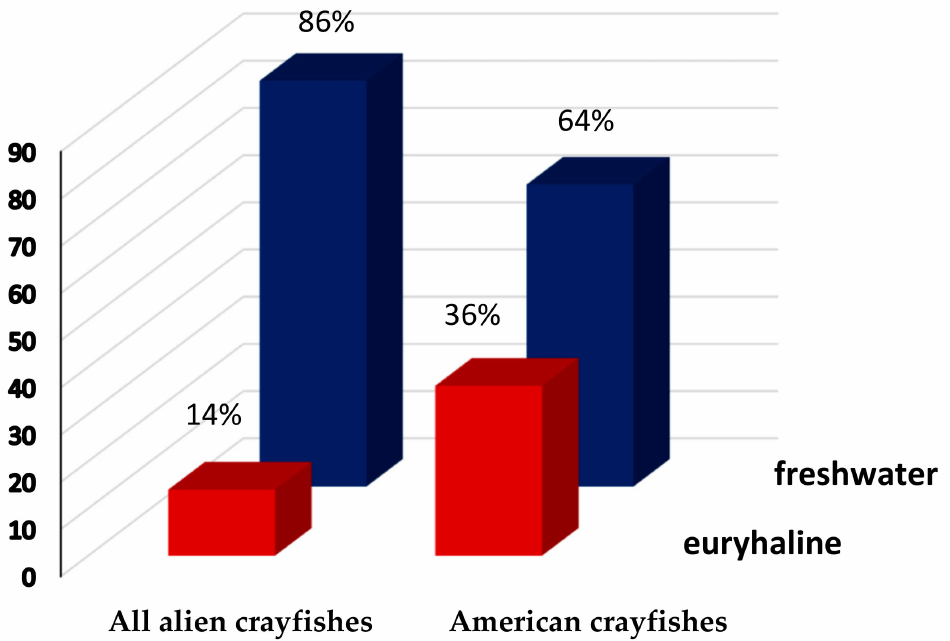
Figure 2. Proportions of global alien crayfish species versus American crayfish species living in freshwater and fresh to saline